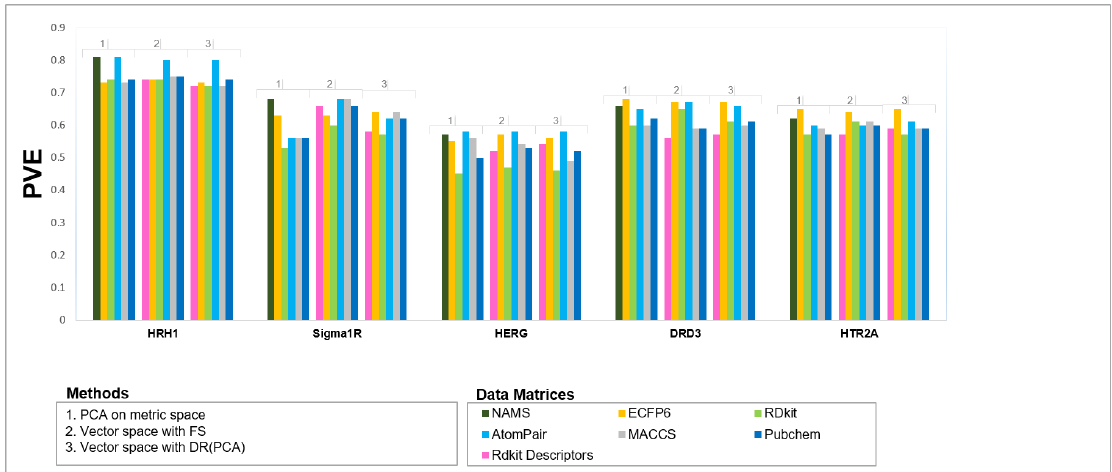
Figure 3. Comparisons of QSAR models’ predictive performance using independent validation sets (IVSs). PVE: percentage of variance explained by the model.